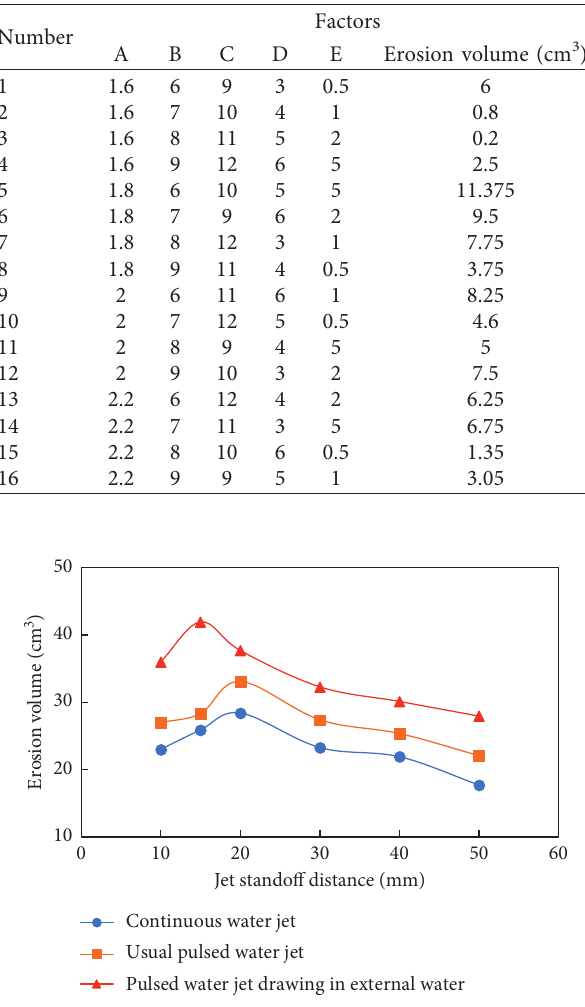
Table 2: The orthogonal experimental results.